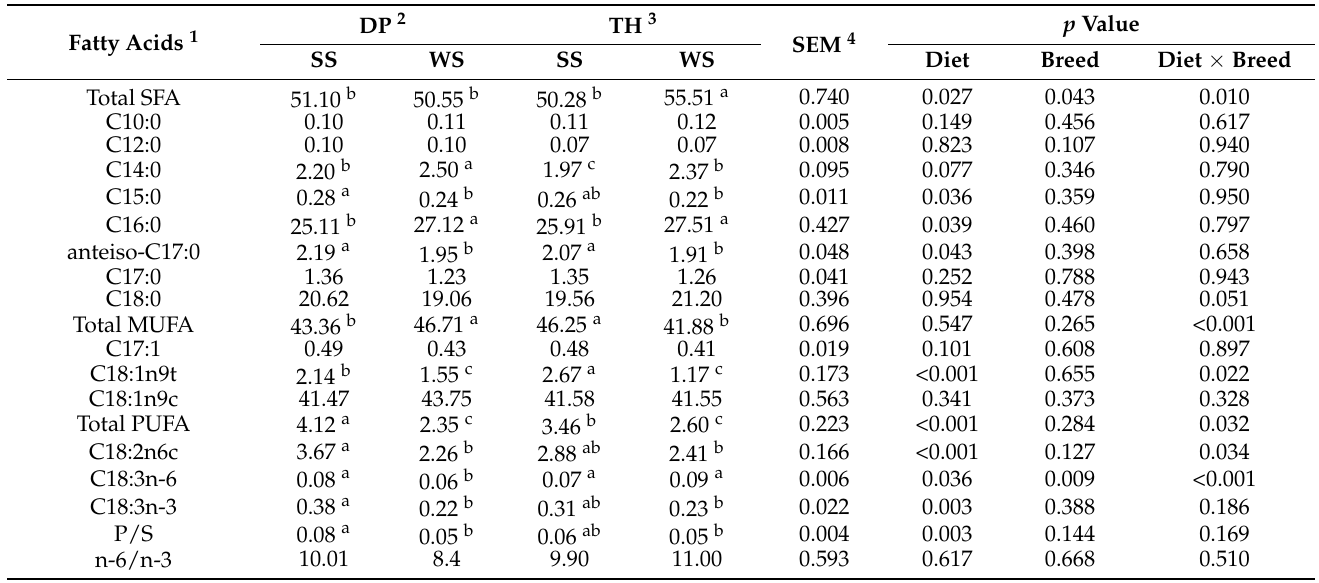
Breed Diet × Breed